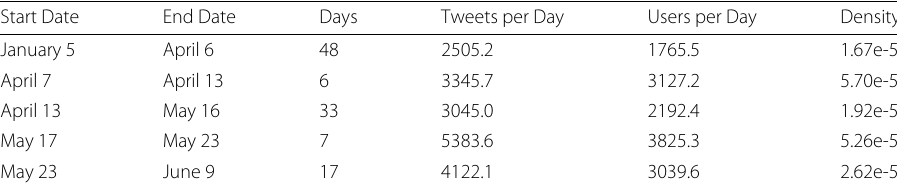
Table 1 Summary statistics for the each Twitter